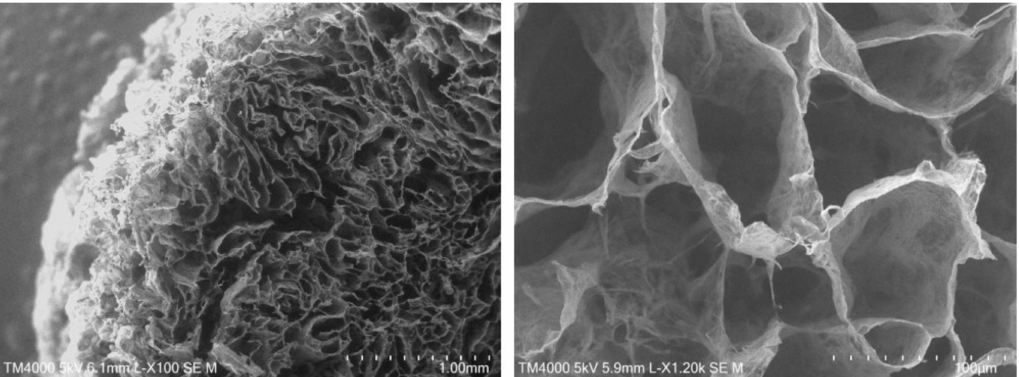
Figure 1. SEM (scanning electron microscopy) images of GO-PEI macrostructure obtained after lyophilization evidencing the porous nature of this